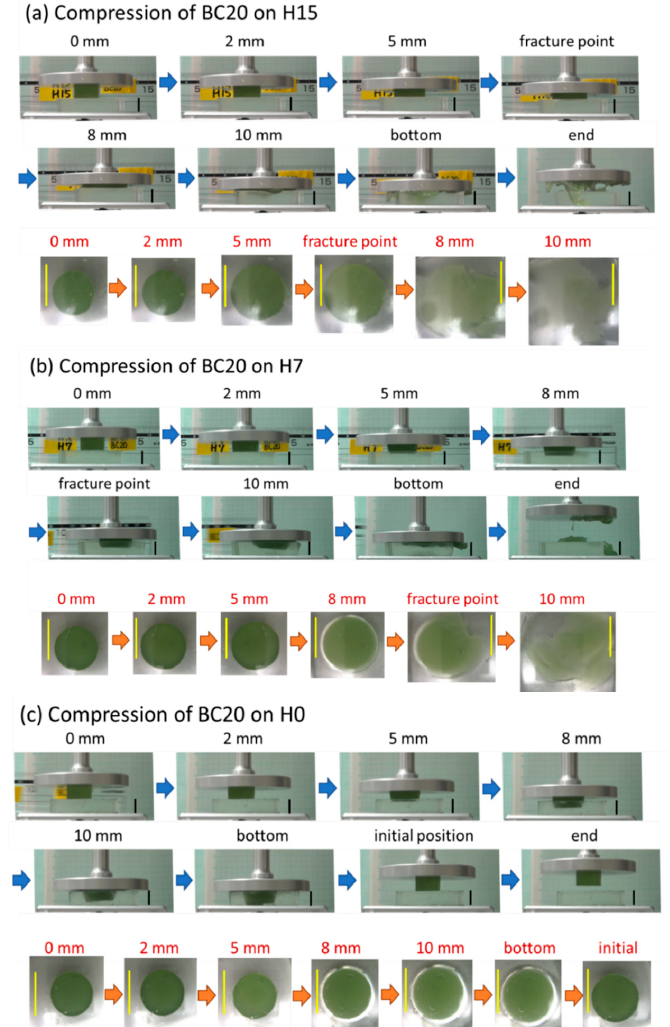
Figure 4. Examples of a food gel on soft material (i.e. as artificial tongue) observed from the side and bottom. Compression process of a BC gel specimen on ( a ) H15, ( b ) H7, and ( c ) H0 artificial tongue. Compression distance from the first contact to the food gel is shown over each snapshot. “Bottom” represents the moment that compression was stopped due to the limit force, “initial position” is the moment that the probe returned to 0 mm height, and “end” indicates the test completion. Black bars are 10 mm as original height of food and artificial tongue gels in the side views, and yellow bars are 20 mm as original diameter of food gels in the bottom views.